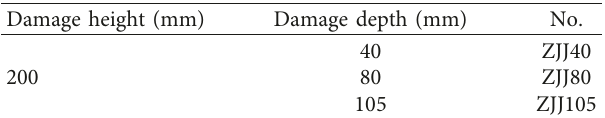
Table 2: Dimensions of the model with unilateral column foot damage.